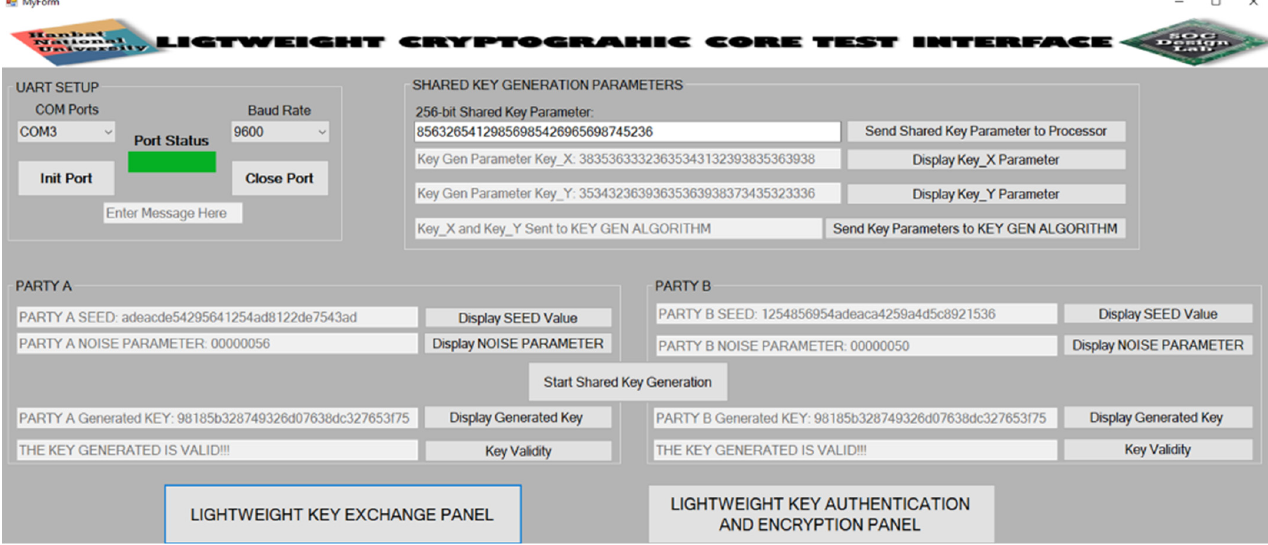
Figure 22. GUI of lightweight key exchange panel.